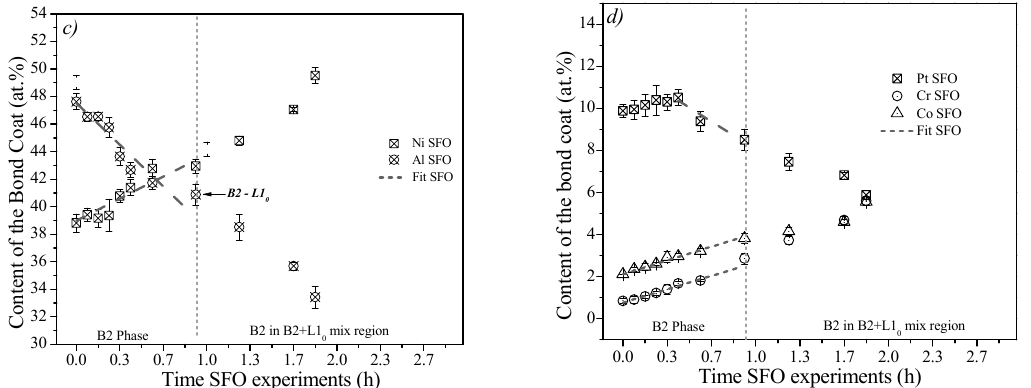
Figure 4. Variation in Al and Ni content as a function of ( a ) NO and ( c ) SFO heat treatment time. The martensitic transformation conditions are indicated at 36.9 at. % Al after 6 h of thermal exposure and at 40.9 at. % Al after 0.92 h of thermal exposure. Variation in Pt, Cr and Co content as a function of ( b ) NO and ( d ) SFO heat treatment time.